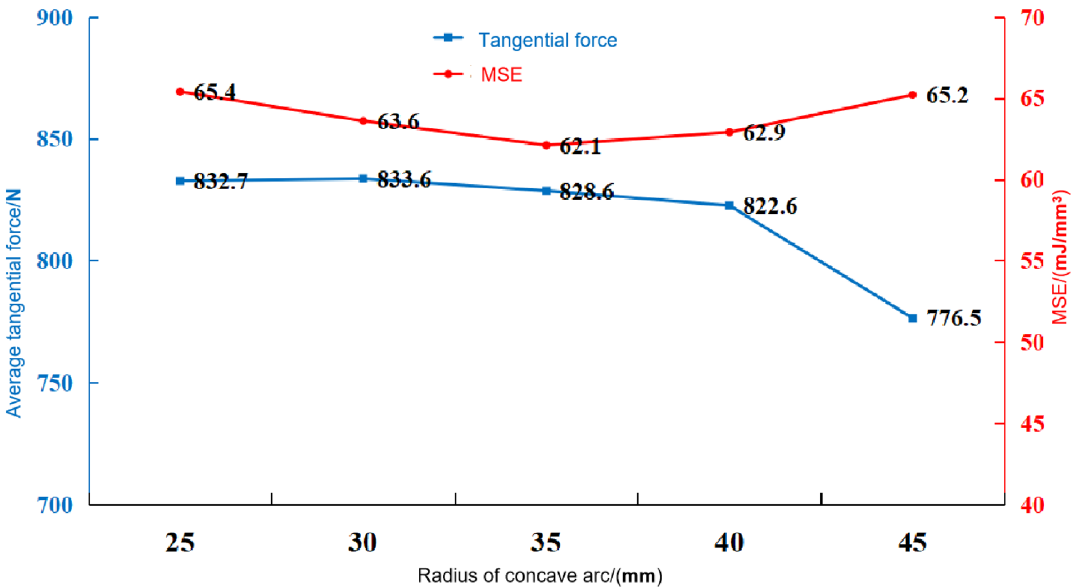
Fig. 9 Tangential force and MSE of different concave arc cutters